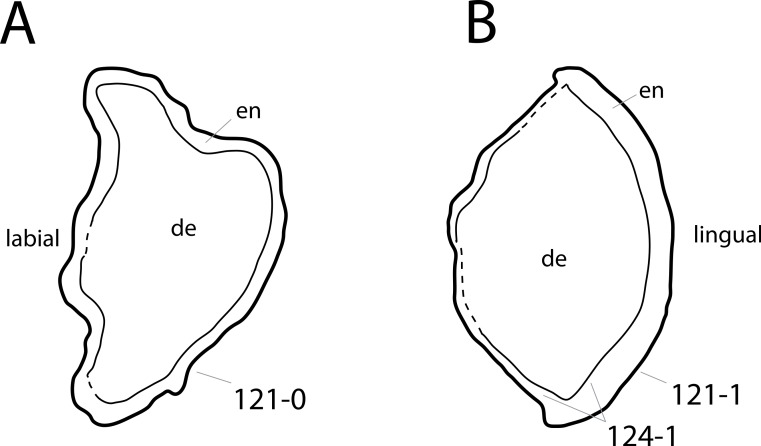
Neosauropod tooth cross-sections.Tooth cross-section of Camarasaurus sp. AMNH 5764 (A), and Demandasaurus darwini MDS-RVII,438 (B; traced from Torcida Fernández-Baldor et al., 2011). Note the D-shaped crown of Camarasaurus (A; C121-0) in contrast with the rounded cross-section of diplodocoids (B; C121-0), and the asymmetric disposition of the enamel typical for rebbachisaurids (B; C124-1). The camarasaur tooth has the same specimen number as the Amphicoelias altus holotype, but does not belong to the same individual (see text). Abb.: de, dentin; en, enamel. Scaled to the same mesiodistal width.